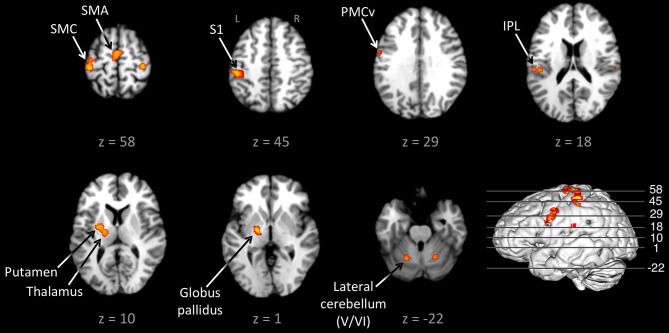
Conjunction between the externally-paced and self-paced ALE maps. The analysis is p < 0.01, FDR corrected. The 3D brain is shown to indicate the slice levels. The slices are shown in neurological convention. Abbreviations: IPL, inferior parietal lobule; L, left; PMCv, ventral part of the premotor cortex; R, right; S1, primary somatosensory cortex; SMA, supplementary motor area; SMC, sensorimotor cortex.